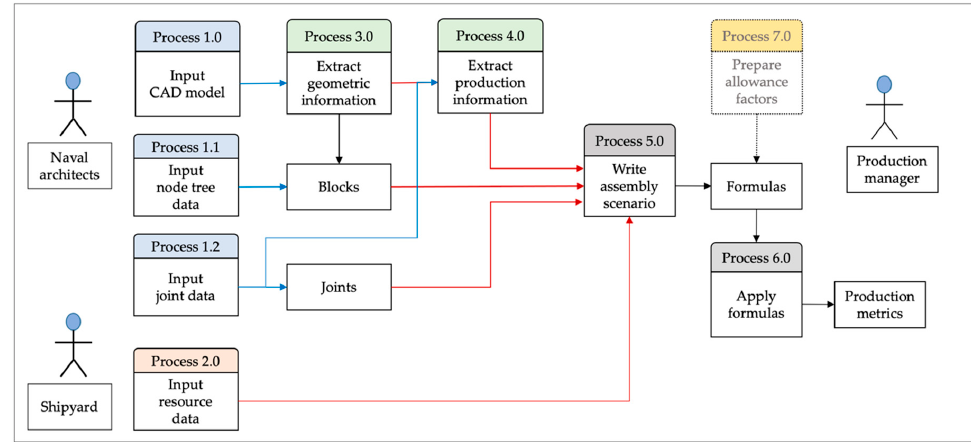
Figure 1. Data flow of production metric estimation